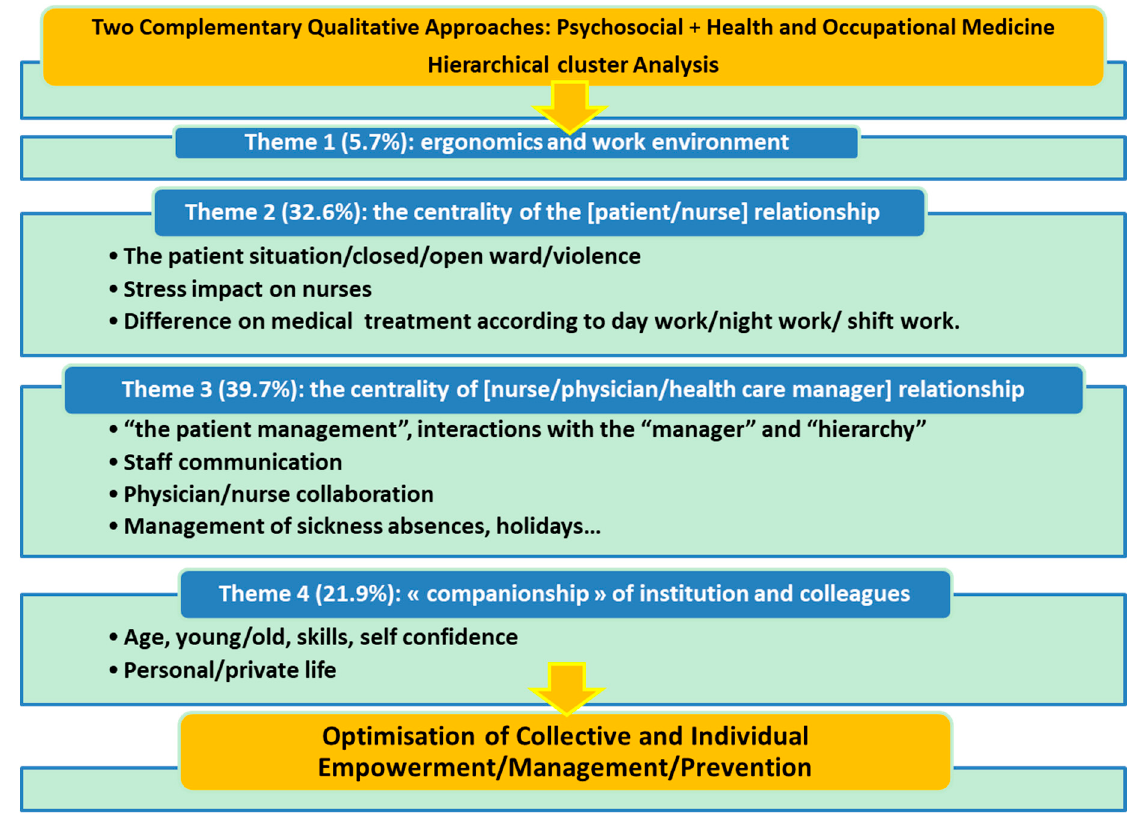
Figure 2. Conceptual map of Health Care Work Empowering.